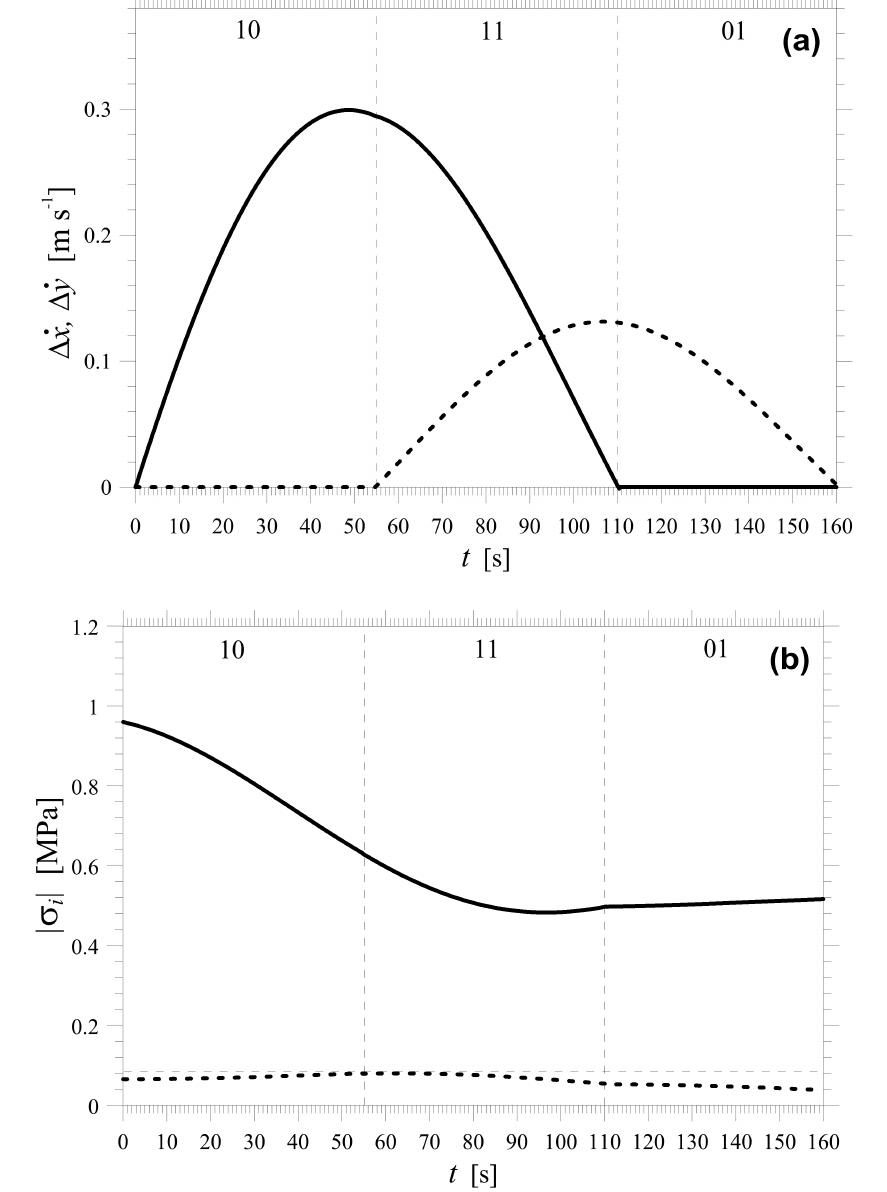
Figure 5. ( a ) Slip rates ∆ ˙ x (solid curve) and ∆ ˙ y (dashed curve) and ( b ) shear stresses σ 1 (solid curve) and σ 2 (dashed curve) as functions of time for asperity 1 and 2, respectively, calculated for the 2010 Maule